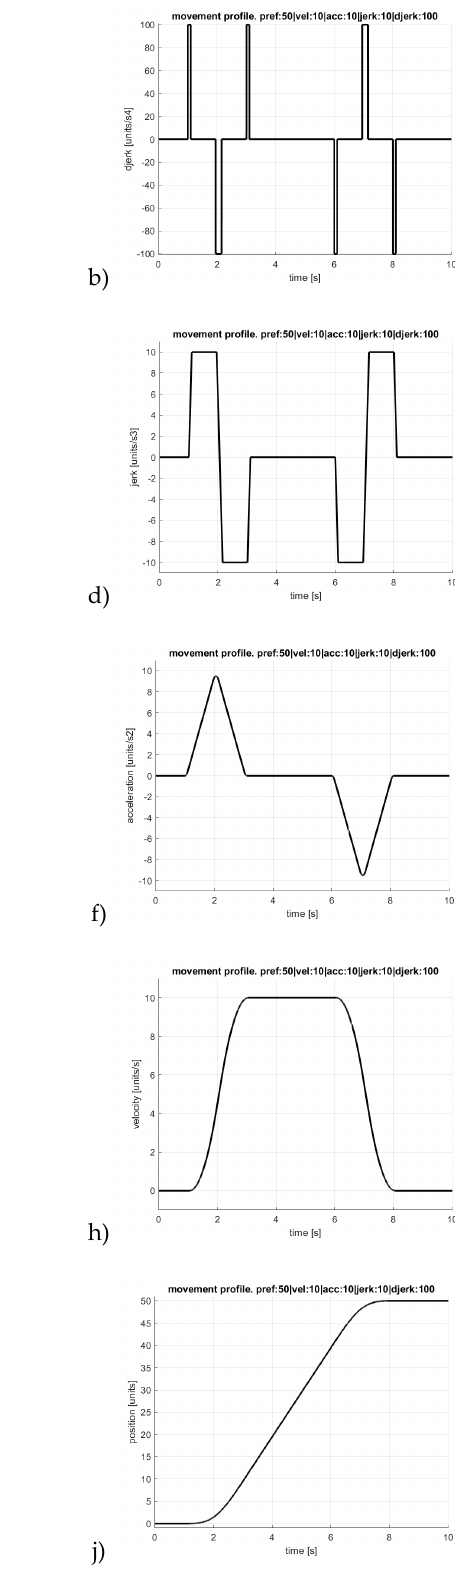
Figure 7. Two examples of generated trajectory profiles: (a, b) derivative of jerk, (c, d) jerk, (e, f) acceleration, (g, h) velocity, (i, j) position